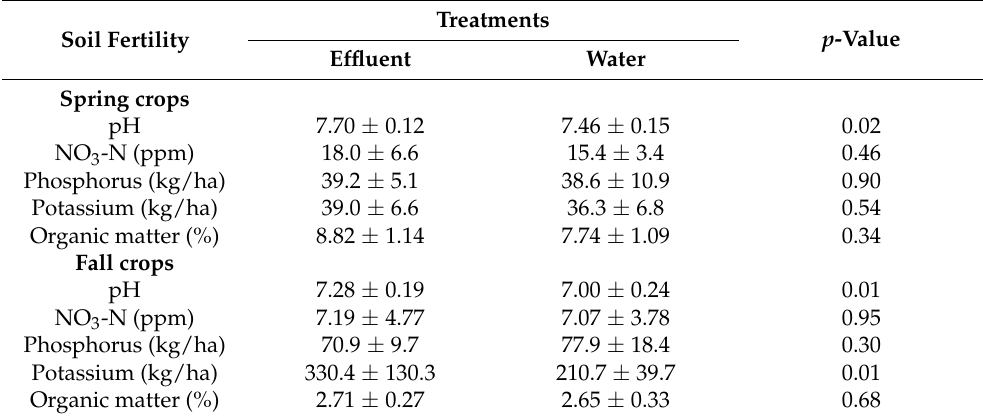
Table 1. End-of-trial means ± standard deviation of soil fertility parameters in blocks irrigated with aquaculture effluent or water.